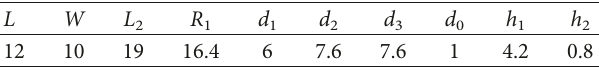
Figure 1: Geometry of the proposed antenna. (a) Three-dimensional view. (b) Side view and top view. Table 1: The structural parameters of the proposed antenna (mm).